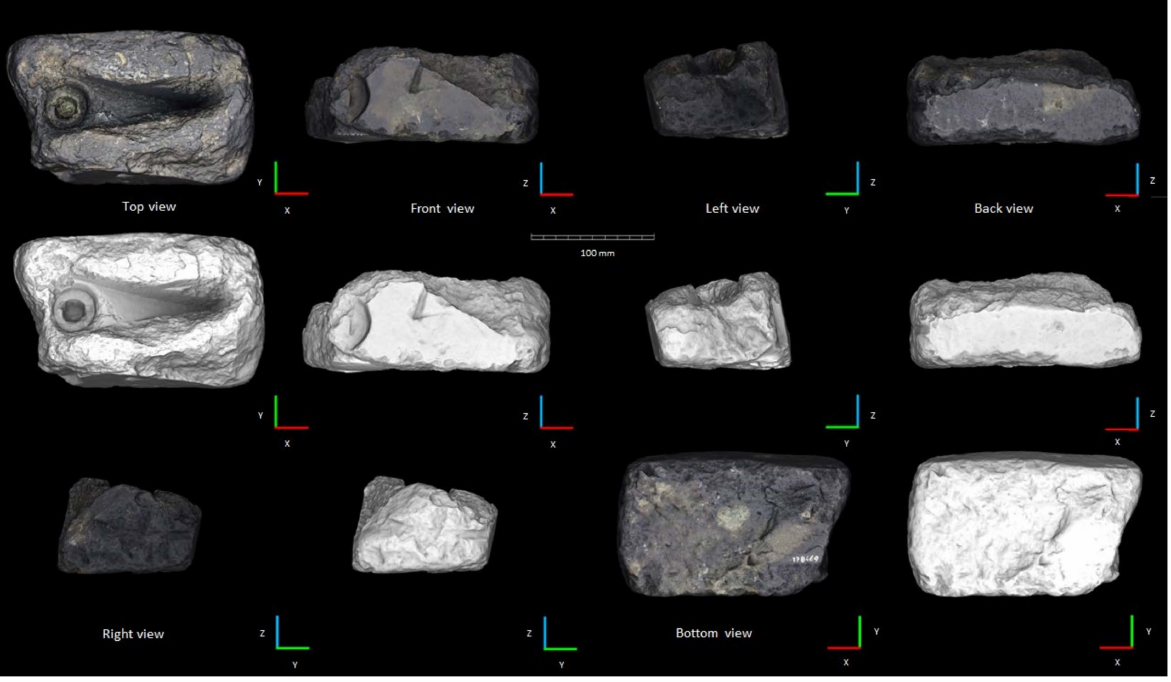
Figure 15. Orthoviews from of S1 3D model, with texture and Shade Vis Plug-in; visualization with CloudCompare